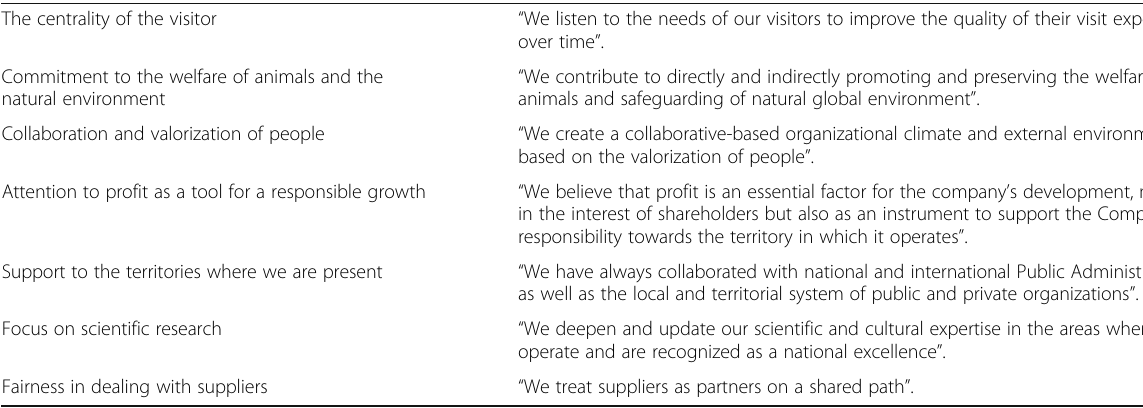
Table 3 The guiding principles of the entrepreneurial action The centrality of the